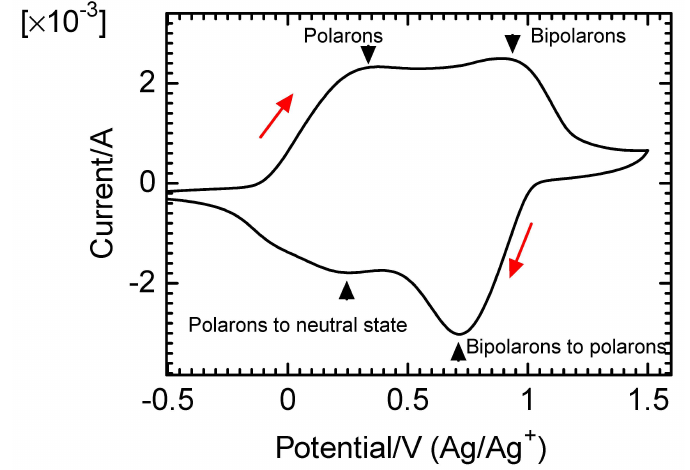
Figure 15. Cyclic voltammetry (CV) of fucoidan/E-PANI(gel) vs. Ag/Ag + as a reference electrode in tetrabutylammonium perchlorate (TBAP, 0.1 M)/acetonitrile solution. Arrows indicate the direction of the